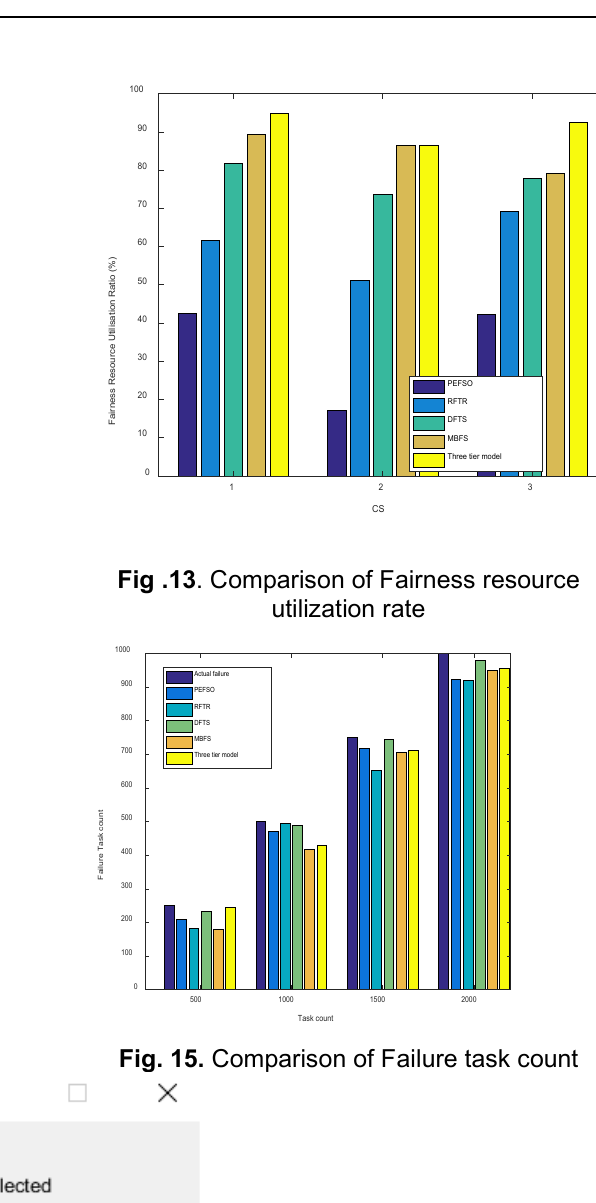
Fig.14 . Comparison of rejection ratio (%) Fig. 15. Comparison of Failure task count